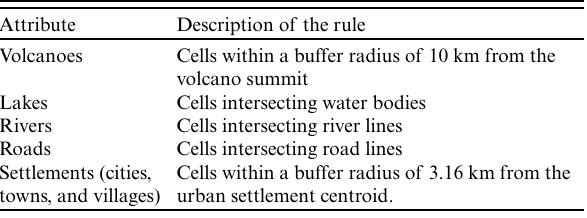
Table 2 . Proximity rules defined to identify attributes that influenced the positioning of marks for natural capital and recreation activities.